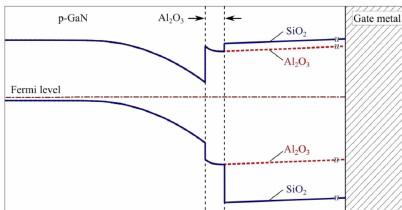
Figure 4. Schematic of the conduction band discontinuity at the Al 2 O 3 / SiO 2 interface within the bilayer dielectric stack, in comparison to the Al 2 O 3 only uni-layer